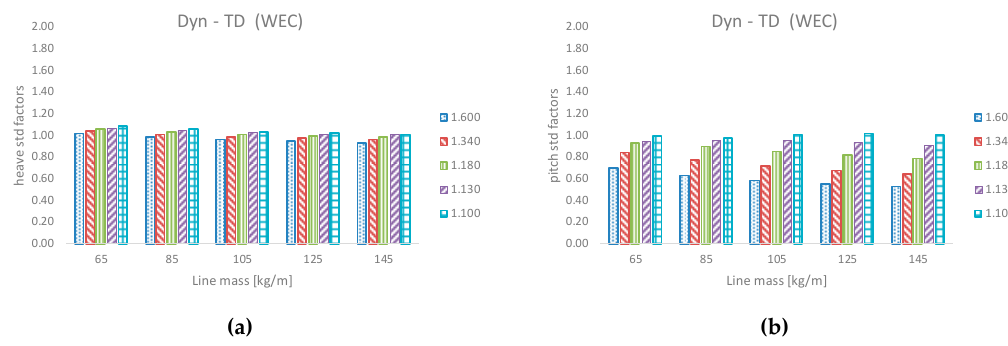
Figure 7. Heaving (a) and pitching (b) std factors of the DynTD models with respect to the QSFD model. Figure 7. Heaving ( a ) and pitching ( b ) std factors of the DynTD models with respect to the QSFD model.